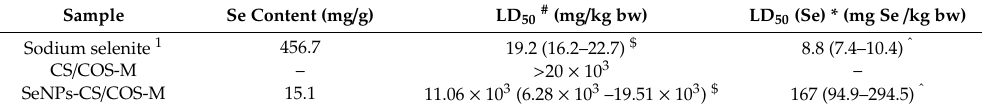
Table 4. Results of the acute lethal test by a single oral administration in KM mice ( n =